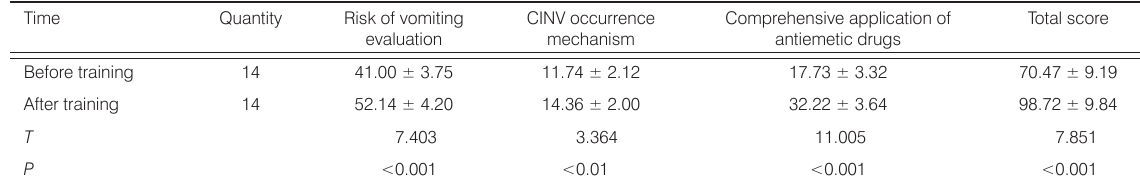
Table 1. Score comparison of chemotherapy-induced nausea and vomiting (CINV) knowledge before and after nurse